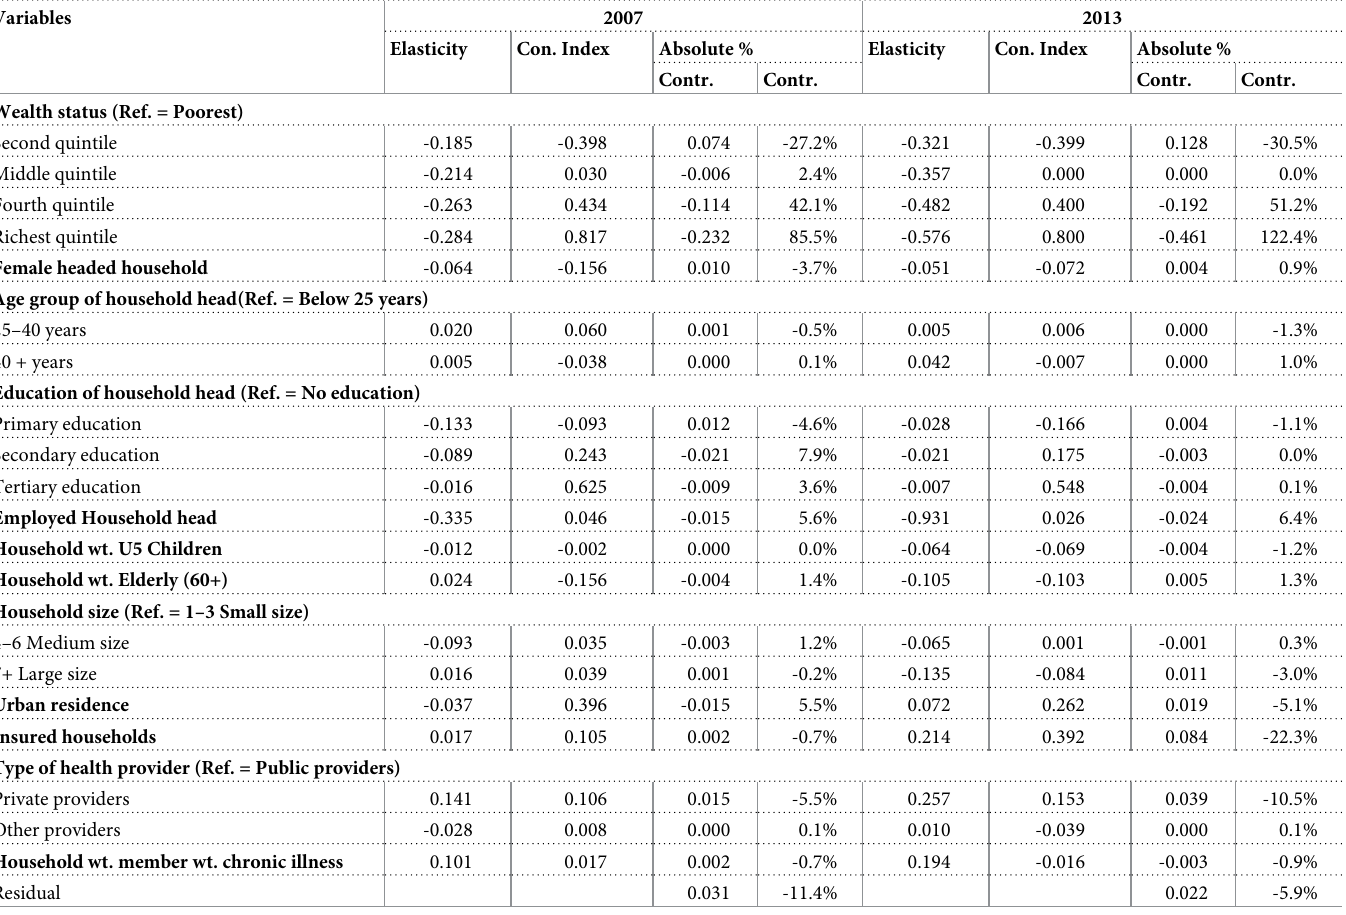
Table 3. Decomposition of inequalities in catastrophic health expenditure, 2007 and